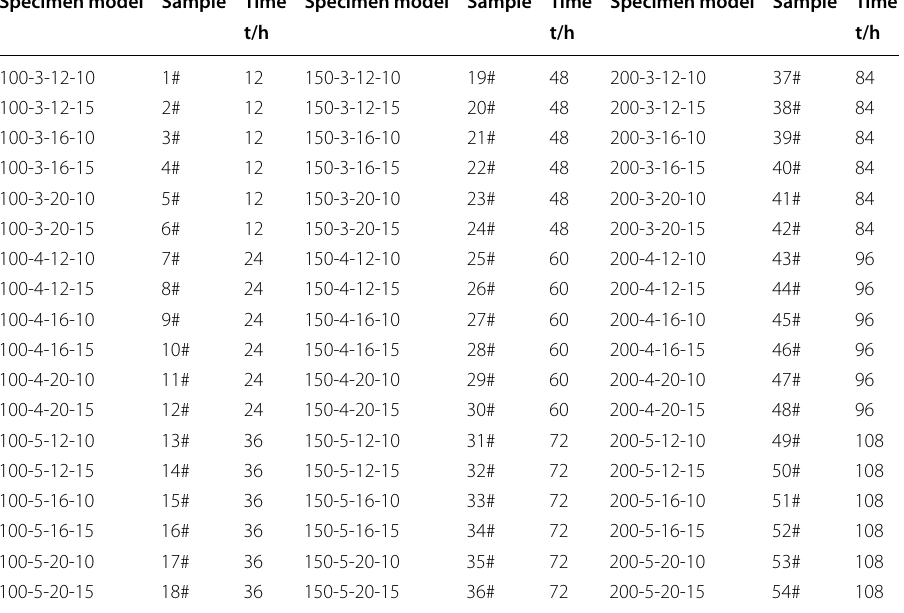
Specimen model Sample Time